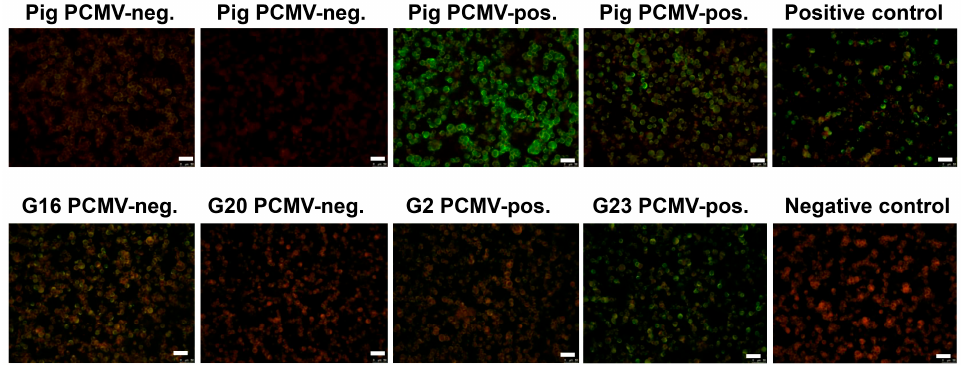
Figure 5. Results of the immunofluorescence analysis of pig and human sera for antibodies reacting against HHV-6. HHV-6 infected cells were used as antigen. In the upper row the reactivity of four pig sera is shown, two of them were PCMV-negative two were PCMV-positive. The “positive control” and the “negative control” are human sera with a known seroreactivity. In the upper row four human sera were analyzed which in parallel were tested on a Western blot analysis using four recombinant proteins of PCMV (Table 5). The bar corresponds to 50 µm.